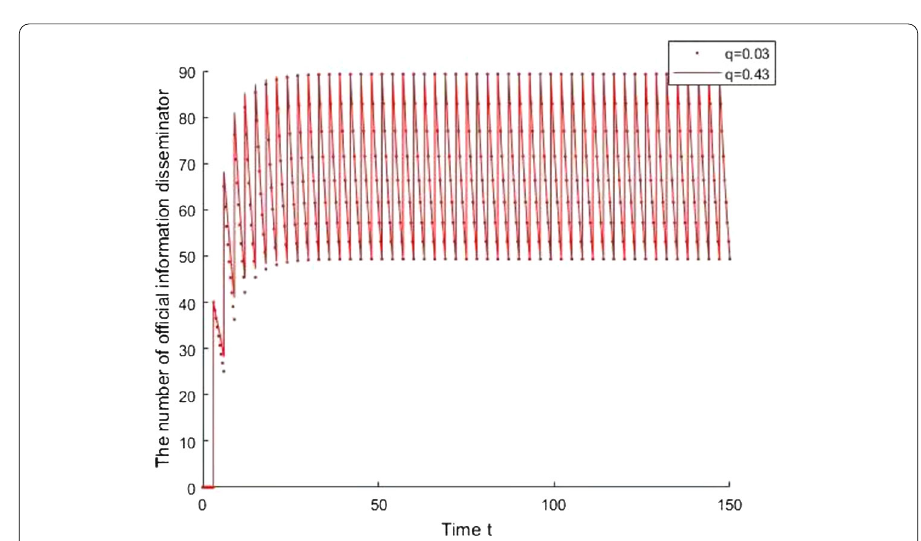
Figure 11 When q < q thr , the evolution graph with different q of y ( t ) are in a periodic solution